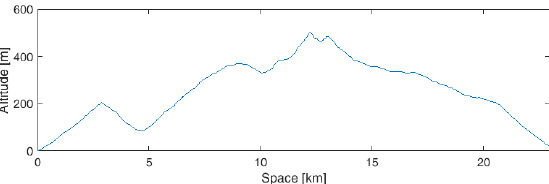
Figure 15. Altitude profile, mountain mission 1.